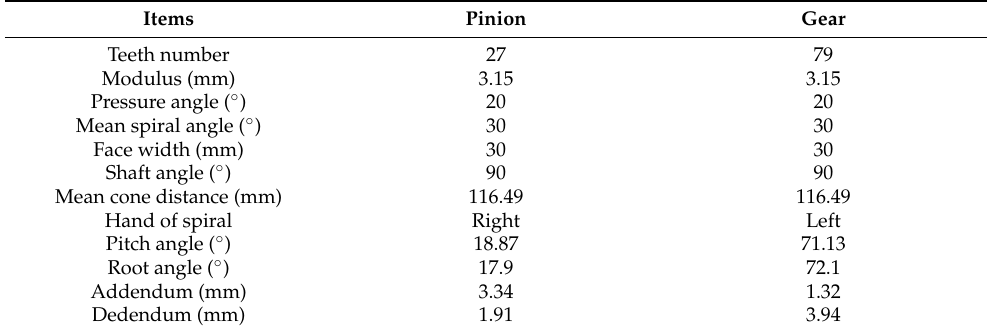
Table 1. Basic Table 1. Basic parameters.